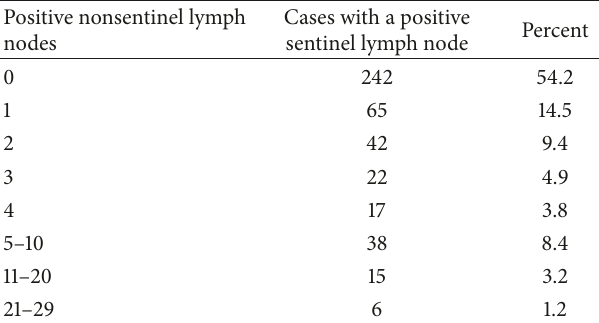
Table 6: Positive nonsentinel lymph nodes following positive sentinel lymph node